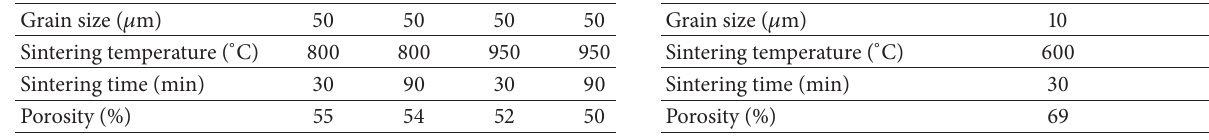
Table 1: Porosity of sintered structures from copper powder with grain size of 50 𝜇 m.